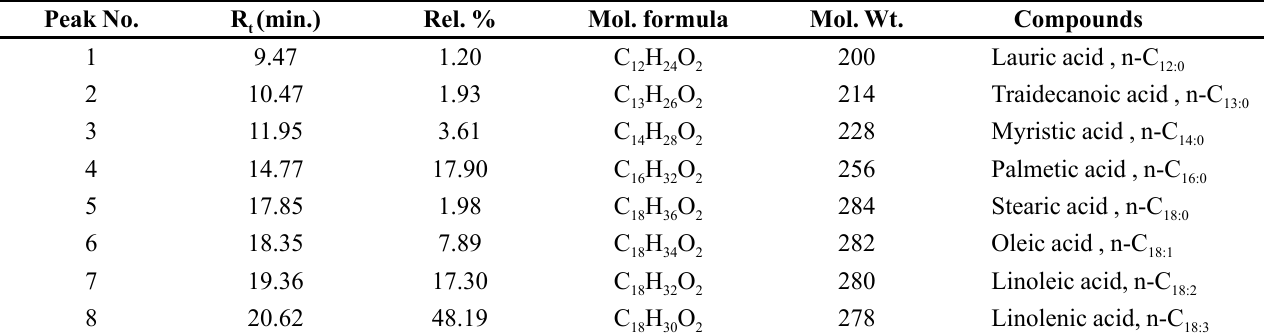
TABLE II - GLC analysis of FAME fraction of Phyllanthus atropurpureus Peak No.